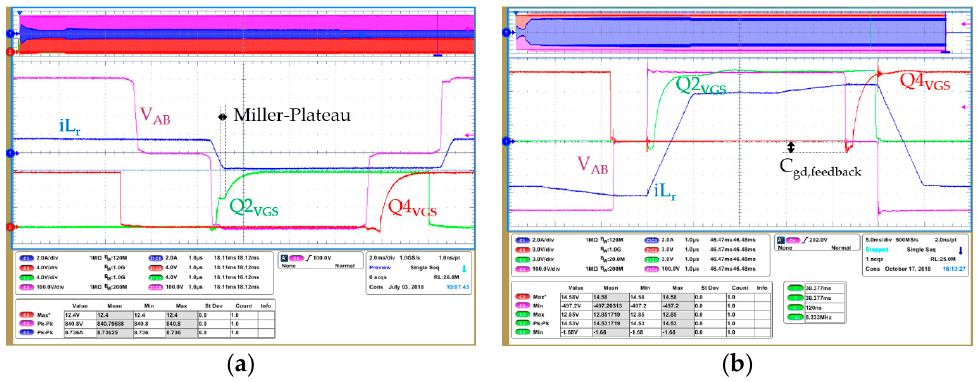
Figure 27. Primary side HV MOSFETs ZVS: ( a ) ZVS at 20 A of load; ( b ) ZVS at full load.